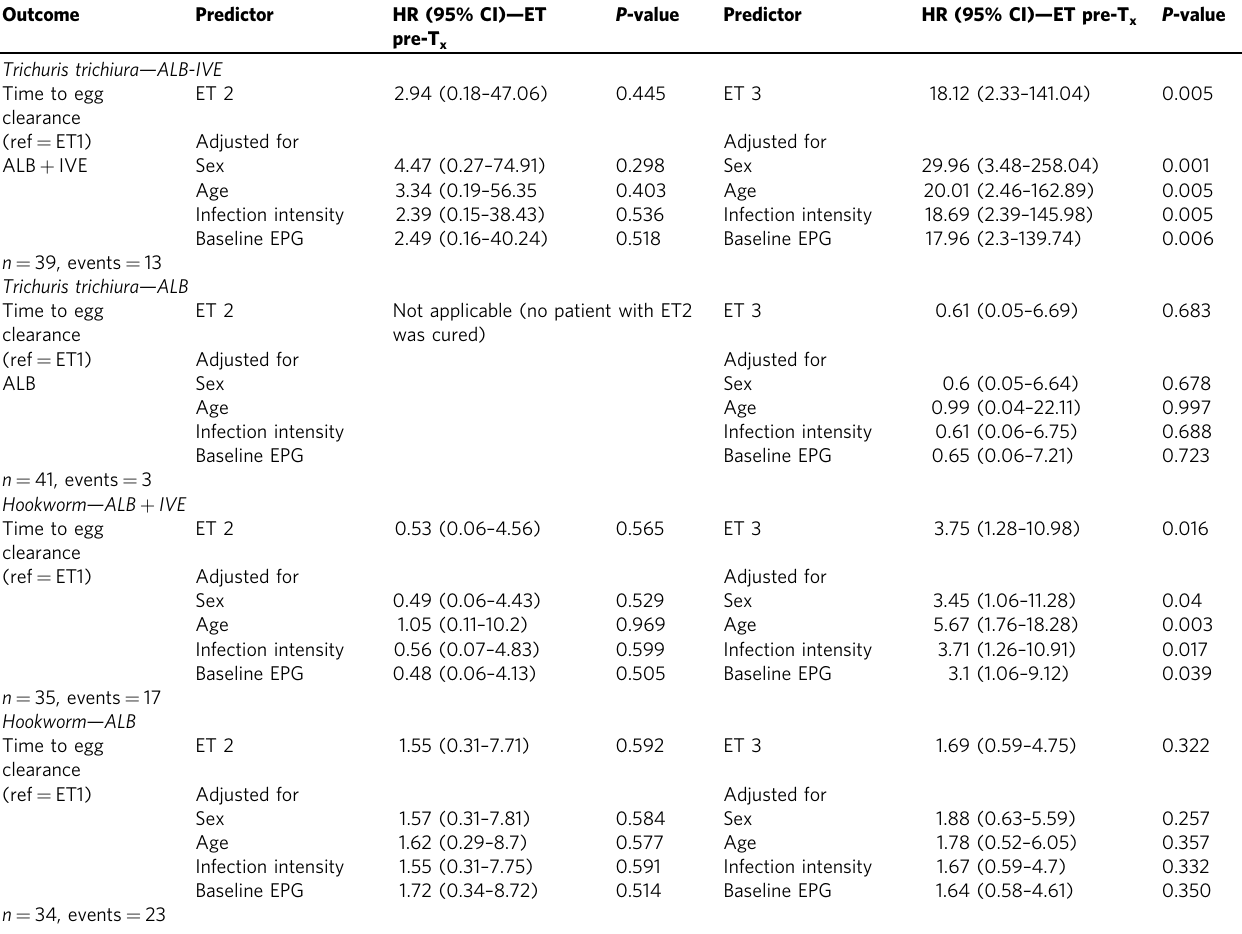
Table 2 Prediction of time to egg clearance using pre-treatment (pre-T x ) enterotypes (ET).